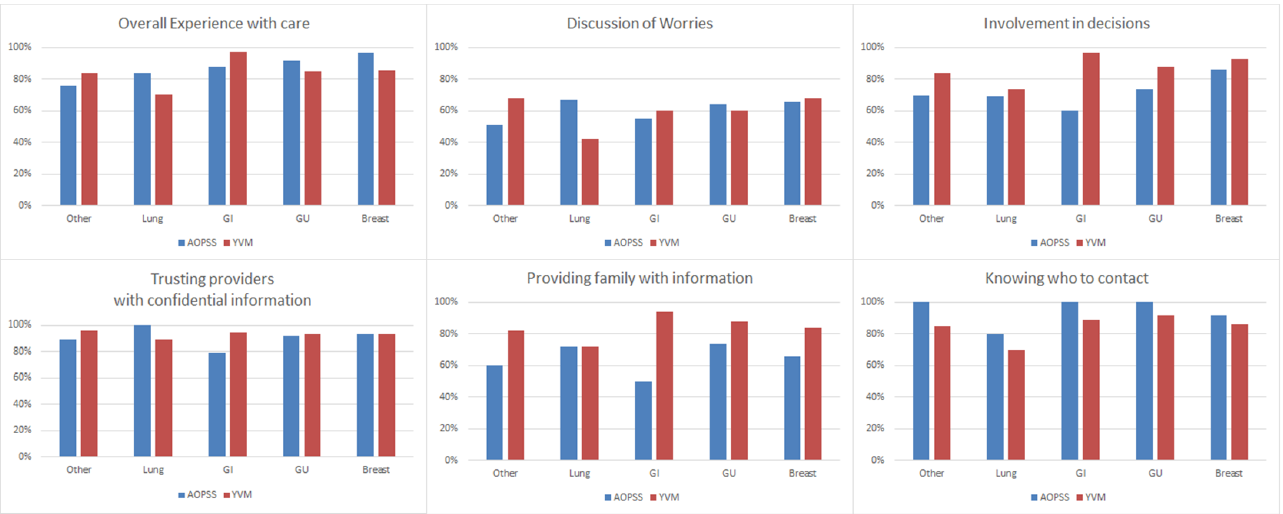
Figure 2. Differences in Positive Experience of AOPSS to YVM by Tumor Group. AOPSS, Ambulatory Oncology Patient Satisfaction Survey; YVM, Your Voice Matters; GI, Gastrointestinal; and GU, Genitourinary.